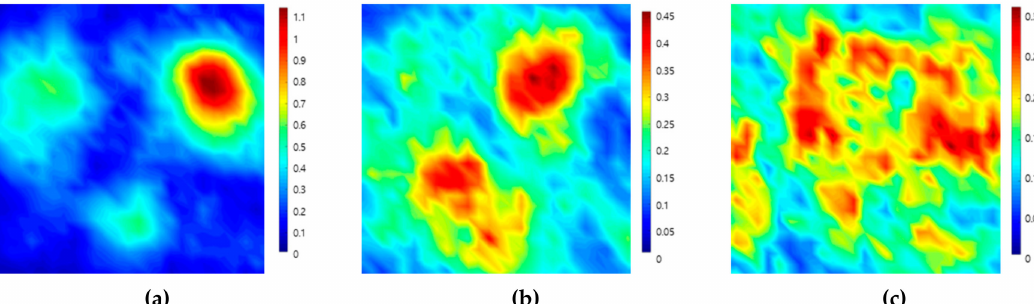
Figure 5. Ultrasonic images acquired by scanning the ( a ) top, ( b ) front, and ( c ) side planes of a coupon specimen using the second back-surface echo and the ultrasonic pulse-echo method.